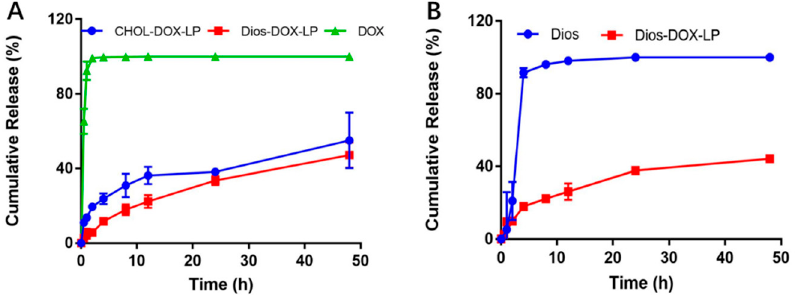
Figure 4. ( A ) In vitro cumulative release of DOX in free DOX, CHOL-DOX-LP and Dios-DOX-LP; ( B ) In vitro cumulative release of Dios in free Dios and Dios-DOX-LP. ( B ) In vitro cumulative release of Dios in free Dios and Dios-DOX-LP.